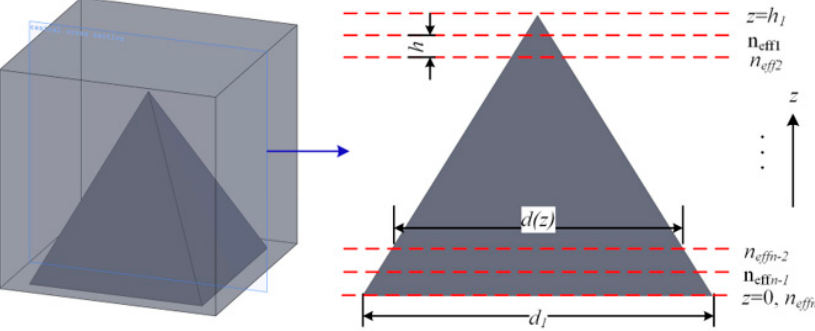
Figure 3. Effective multi-layer model of the tip of the pyramidal micro-nano structure. The filling rate f j of each layer could be obtained as follows: